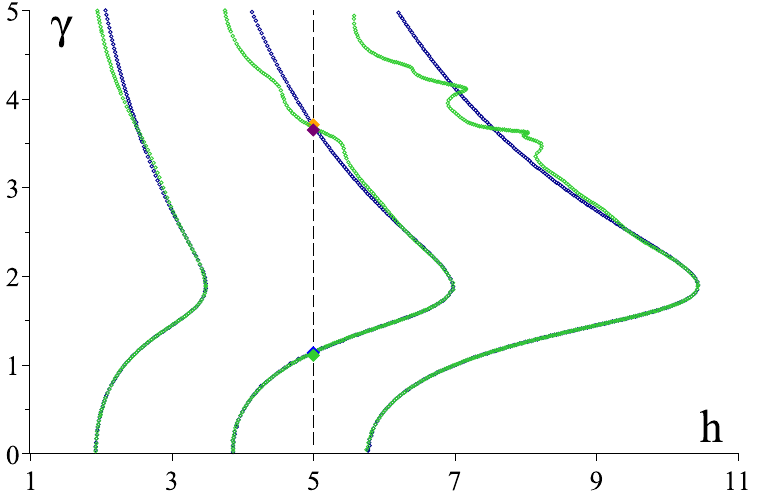
β α (green curve) P 1.141 (blue), ≈ 1.115 (green), (cid:98) γ 2,2 3.656 ≈ ≈